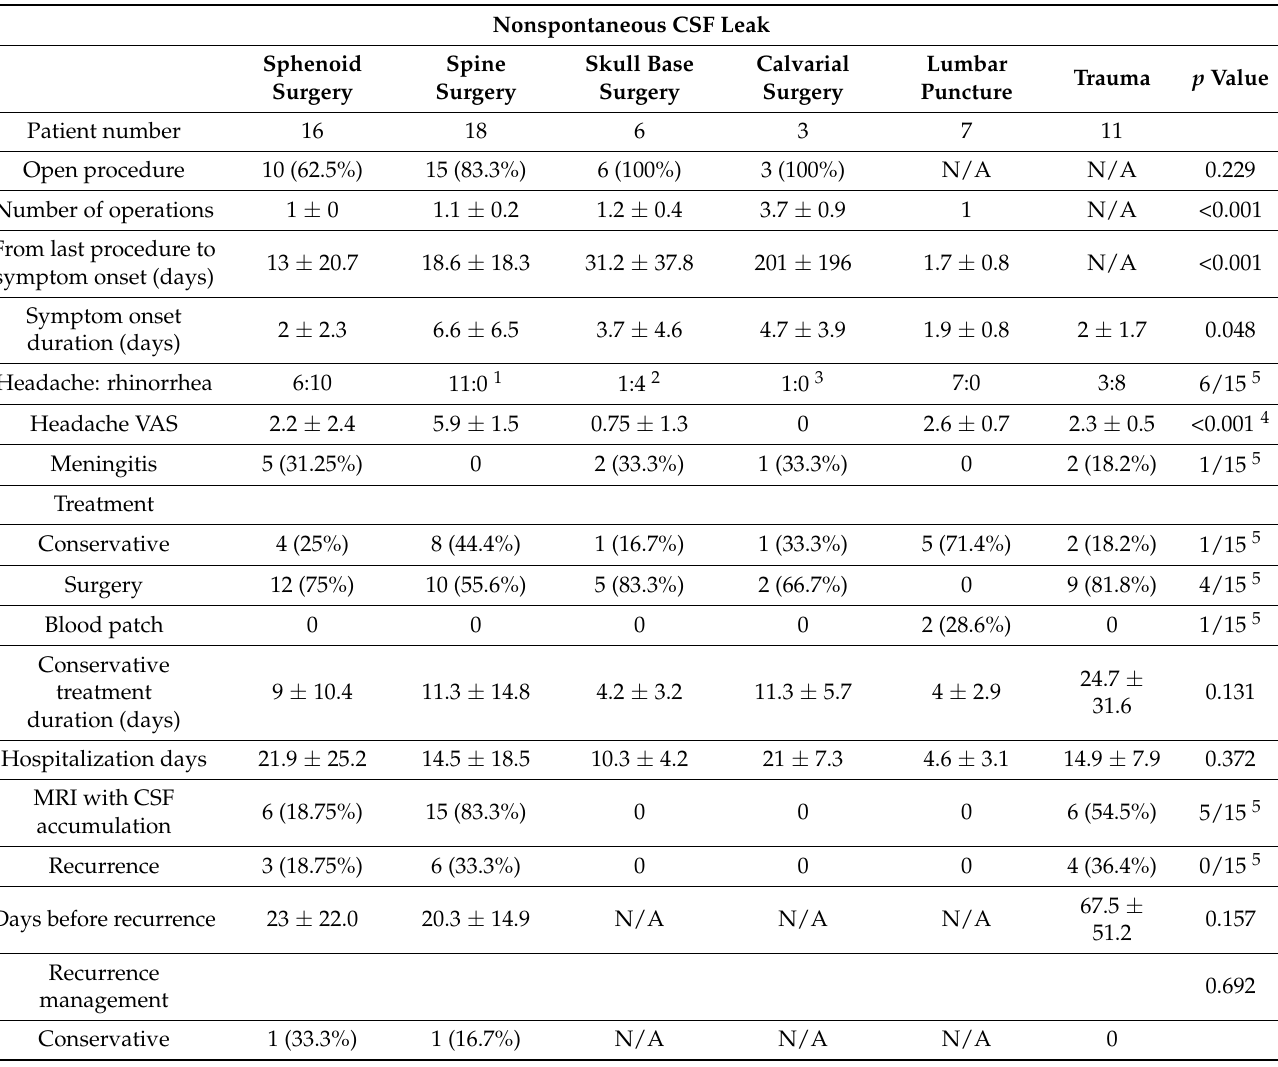
Table 2. Subgroup analysis of nonspontaneous CSF